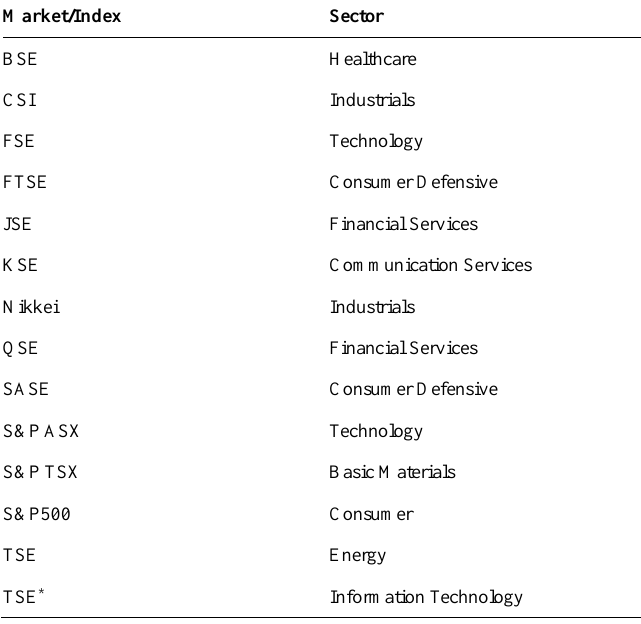
Table 19. The main information receiver sectors, after